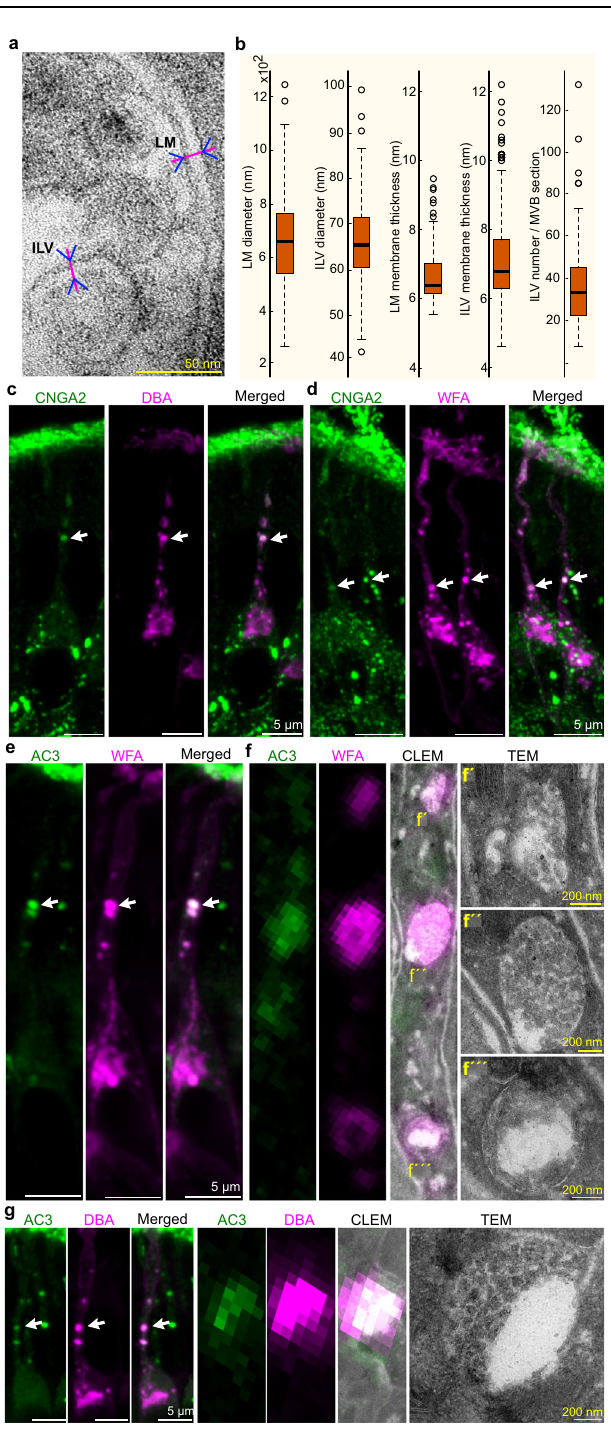
Fig. 2 | Characterization of MVTs and analysis of lectin staining by CLEM. a High-resolution TEM images showing the limiting membrane (LM) and ILV membranes with magenta and blue distance markers crossing the membranes in ultrathin section. b Boxplots showing the diameter, limiting membrane thickness and ILV membrane thickness aswell asthe number of ILVs per section of MVB-like organelles. Data is from 97 OSNs ( N =7 mice). Sample sizes were n =137 (LM dia- meter), n =144 (ILV diameter), n =66 (LM membrane thickness), n =443 (ILV membrane thickness) and n =135 (ILV number per MVB section). The box in plots denotes the interquartile range (IQR) i.e. median (line within box)±25 – 75 per- centiles. Whiskers show rest of the data distribution (±1.5×IQR) and outliers are indicated by circles. Data is in source data fi le. Density of ILVs per MVB-like orga- nelle section, falling within the IQR, is 112±6 ILVs/ µ m 2 ( n =70). Estimates of